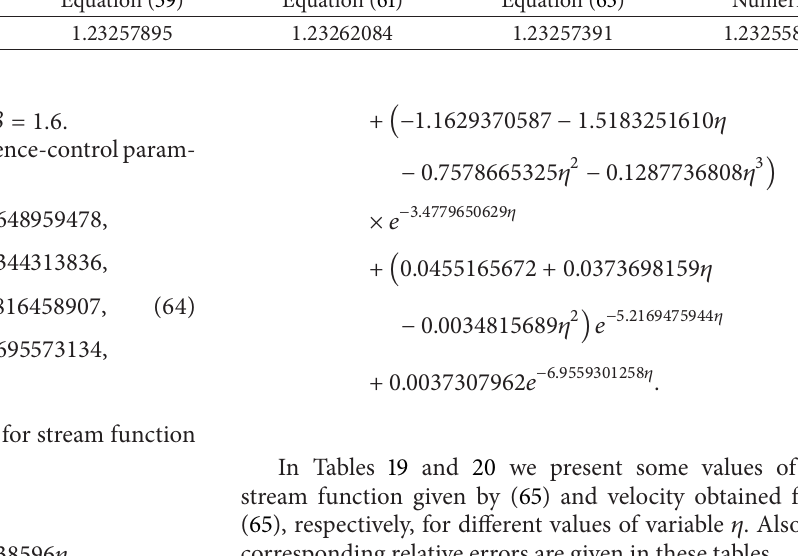
Table 18: Comparison between the values of 𝐹 Type of